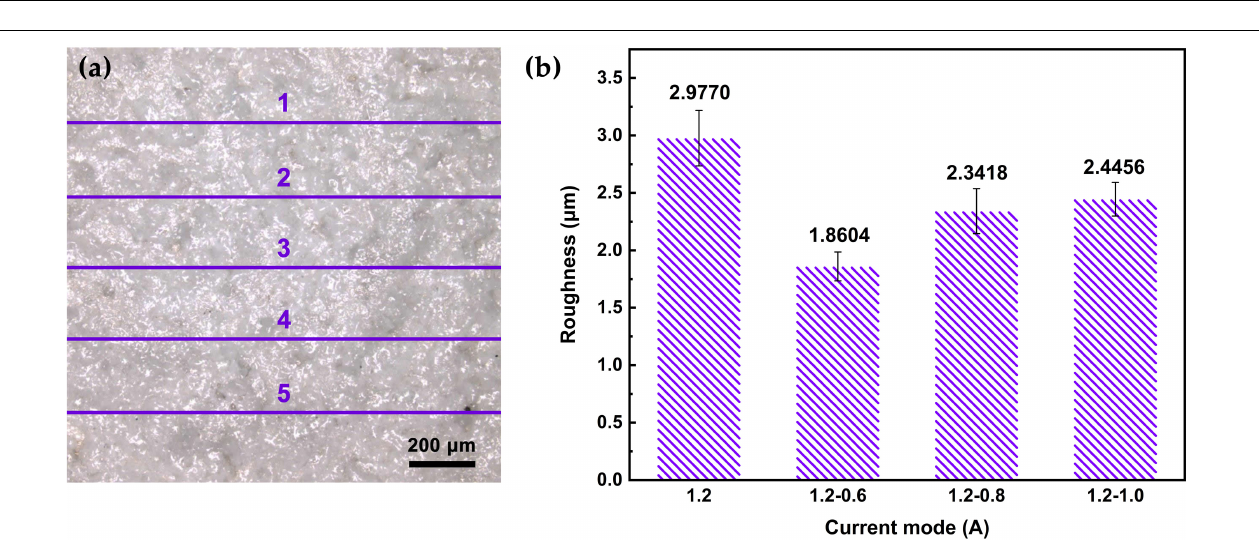
FIGURE 5 | (a) Schematic image of MAO coating roughness measured by five lines; (b) roughness of MAO coatings under different current modes.